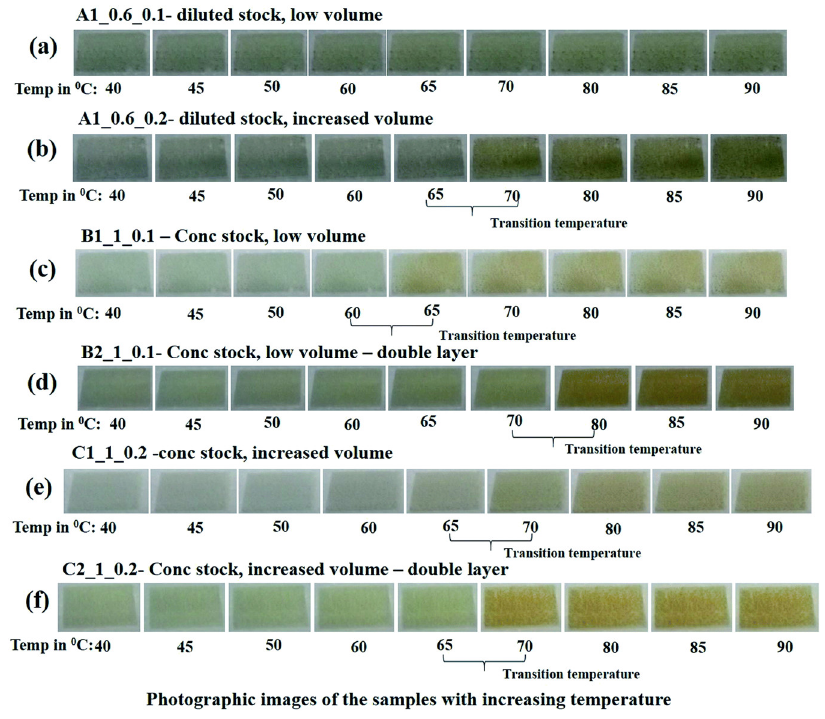
Figure 10. The photographic images of the samples (collected from the captured videos) heated at temperatures from 40–90 °C in steps of 5 °C. Reproduced with the permission of Reference [36]. Copyright The Royal Society of Chemistry.